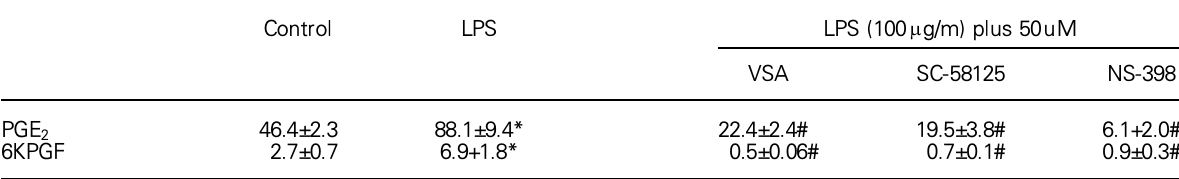
Table 3. The effect of cyclooxygenase 1 and 2 inhibitors on LPS stimulated prostaglandin E2 and prostacyclin (6-keto PGF 1 formation (ng/mg cell protein) by human intestinal smooth muscle cells.